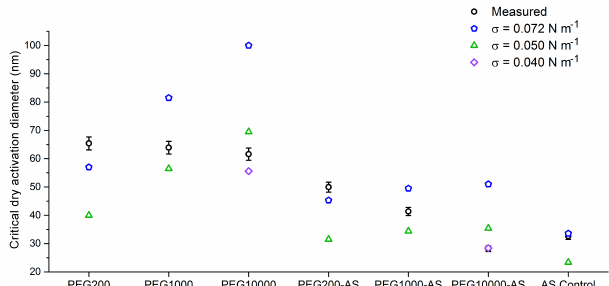
Figure 3. Critical dry particle diameters ( D crit ) at a water supersat- uration of 0.8% at 298K for the PEG, PEG–AS, and AS control aerosol systems determined from CCN measurements (black cir- cles) and calculated using AIOMFAC with classical Köhler theory assuming a range of droplet surface tensions ( σ) . Values of D crit were determined from CCN measurements by fitting the activation- fraction measurements with sigmoidal curves, as shown in Fig. 2, and determining the dry particle diameter associated with an activa- tion fraction of 50% using these curves. Error bars on D crit indicate an assumed uncertainty in the DMA-transmitted particle diameter of